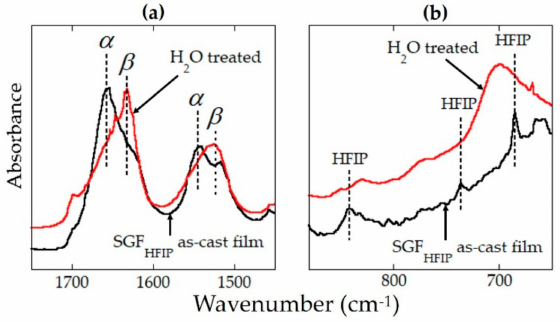
Figure 9. FTIR spectra of S. c. ricini as-cast (spectrum in black) and water-treated (spectrum in red) SGF HFIP films. The vibrational bands in the amide I and II regions are shown in panel ( a ), whereas those assigned to HFIP are shown in panel ( b